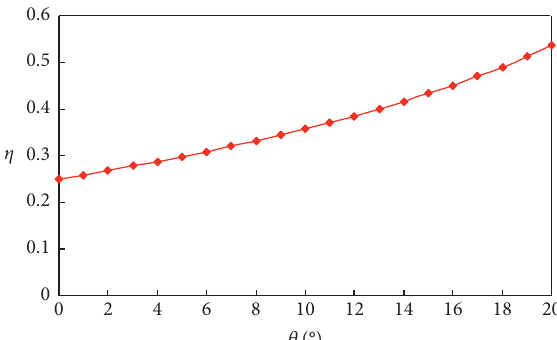
Figure 6: Relationship between θ (angle between the fracture line and vertical line) and η (ratio of thickness to span) during the first